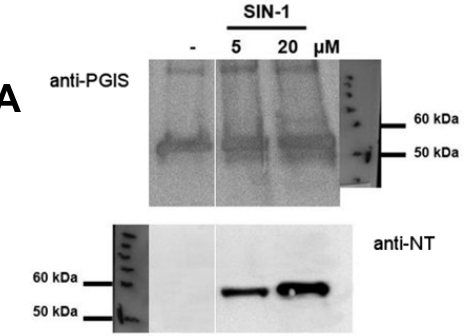
Figure 4. Nitration of purified, recombinant PGIS by in situ generated peroxynitrite. ( A ) Detection of 3-nitrotyrosine in PGIS by Western blot analysis using a polyclonal amti-PGIS antibody and a monoclonal anti-3-nitrotyrosine antibody. PGIS (300 nM) was treated with peroxynitrite generated in situ from Sin-1 (5 and 20 μ M). Data are representative of two independent experiments; ( B ) Detection of 3-nitrotyrosine in PGIS by dot blot analysis using a monoclonal anti-3-nitrotyrosine antibody. PGIS (80 nM)